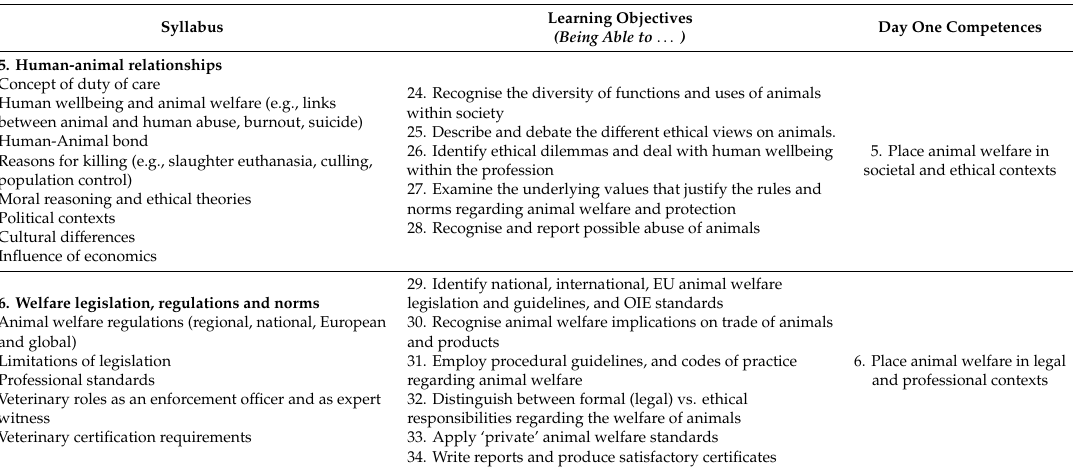
Learning Objectives (Being Able to ...